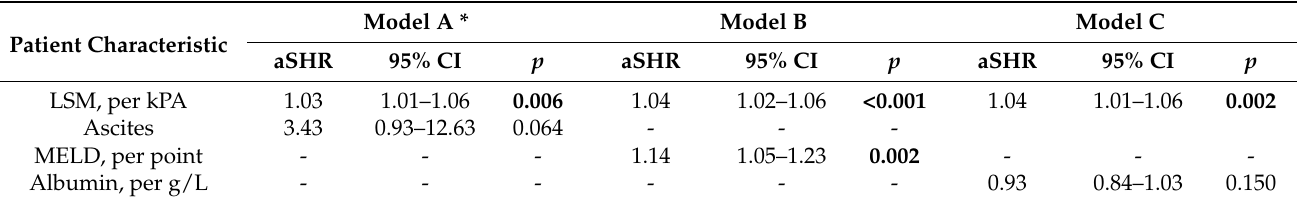
Table 2. Multivariate competing risk regression models with hepatic decompensation as outcome of interest and liver transplantation, diagnosis of hepatocellular carcinoma and non-liver-related death as competing risks. The parameter of interest (VCTE-LSM) is compared with the parameters that showed prognostic value in univariate analysis, i.e., (A) presence of ascites, (B) MELD and (C) albumin